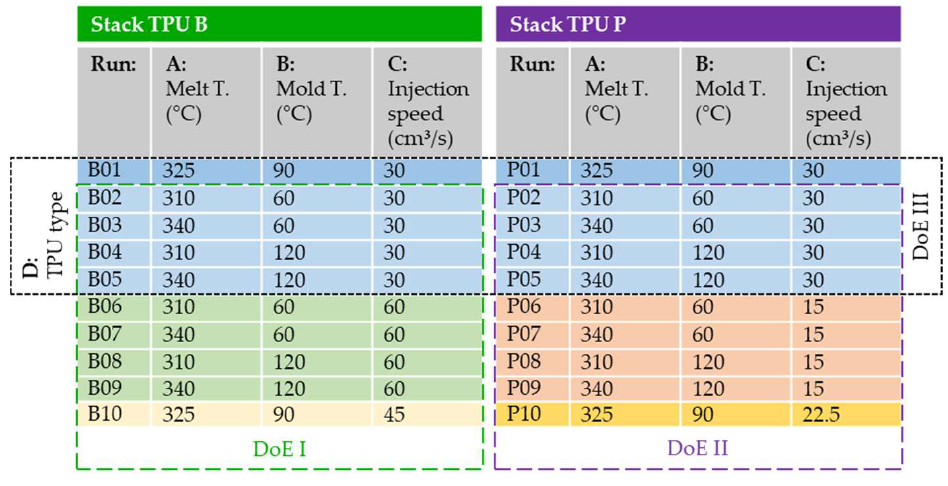
Table 1. Experimental design for the overmolded parts with film strips. For each setting, 3 parts are produced (60 parts in total).